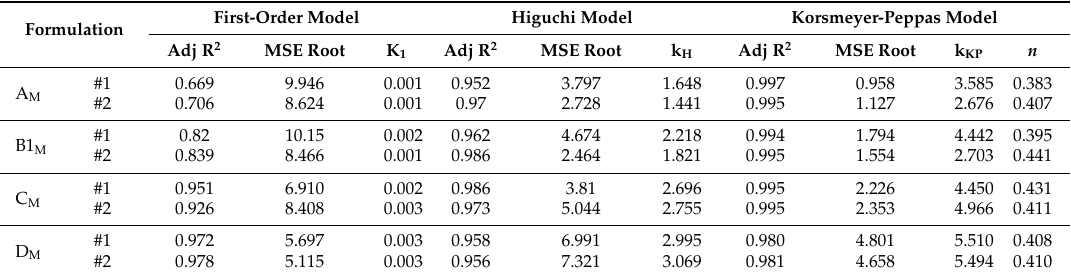
Table 3. Fitting of dissolution models to OLZ release data for